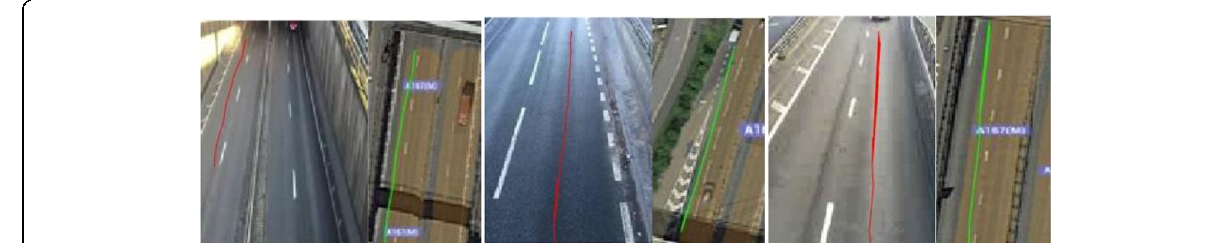
Fig. 10 Vehicle chaotic trajectories on video and map